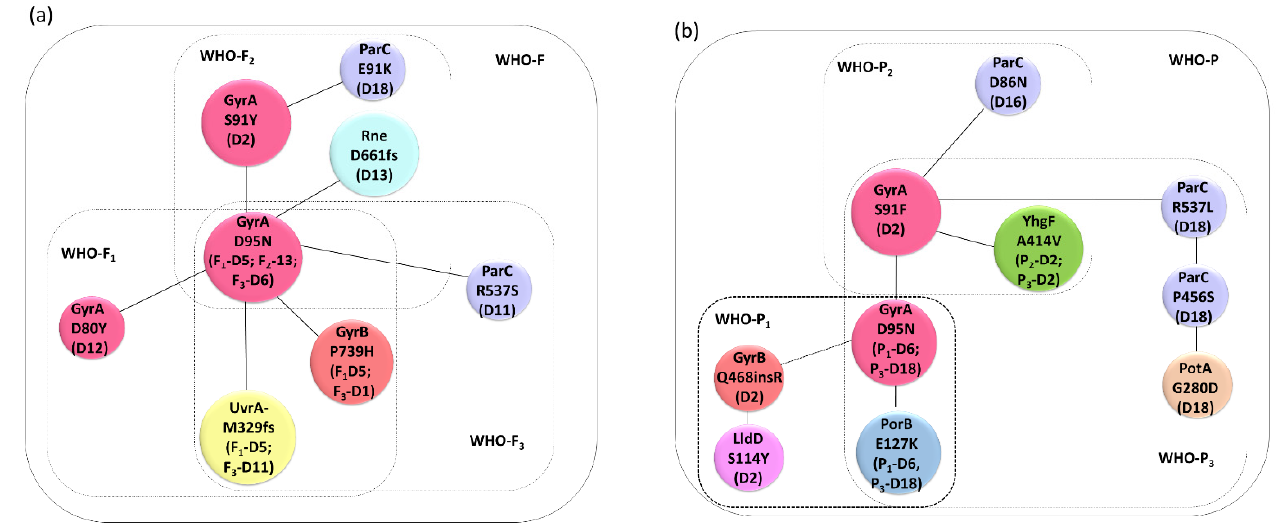
Figure 3. Association network of genes putatively associated with ciprofloxacin resistance in ( a ) WHO-F and ( b ) WHO-P strains. The clones and the days are denoted in parenthesis.